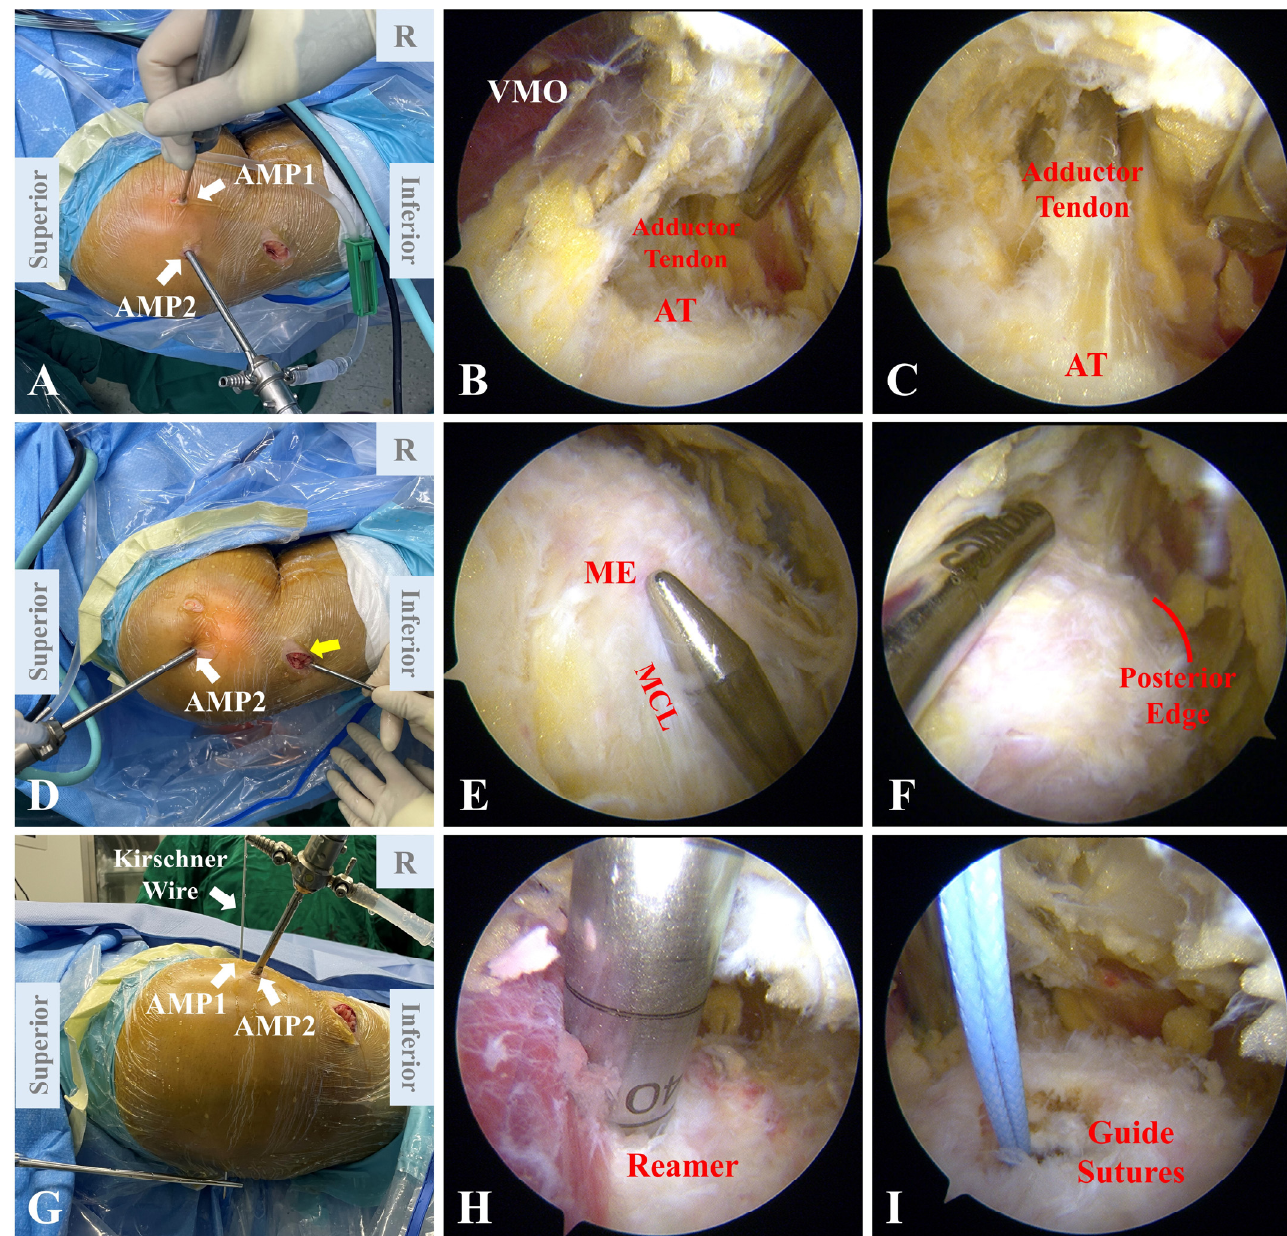
Figure 4. Positioning of femoral tunnel. ( A ) The arthroscope is placed through the AMP2 and a shaver is placed through the AMP1. ( B ) Under arthroscope, the VMO is first localized, followed by identification of the adductor tendon that lies flat against the distal part of the VMO. ( C ) The bony process where the adductor tendon attaches to the femur is identified as the AT. ( D ) The arthroscope is placed through the AMP2, and a blunt obturator is introduced through the incision for graft harvest (yellow arrow). ( E ) The blunt obturator is placed along the MCL arthroscopically, with its tip indicating the femoral attachment of the MCL, namely the ME. ( F ) The posterior edge is clearly exposed. ( G ) After the position of the femoral tunnel is confirmed, a Kirschner wire is introduced through the AMP1 and penetrates the femoral condyle. ( H ) A reamer is used to drill the femoral tunnel. ( I ) Guide sutures are passed through the tunnel. AMP, auxiliary medial portal. AT, adductor tubercle. MCL, medial collateral ligament. ME, medial epicondyle. VMO, vastus medialis oblique.